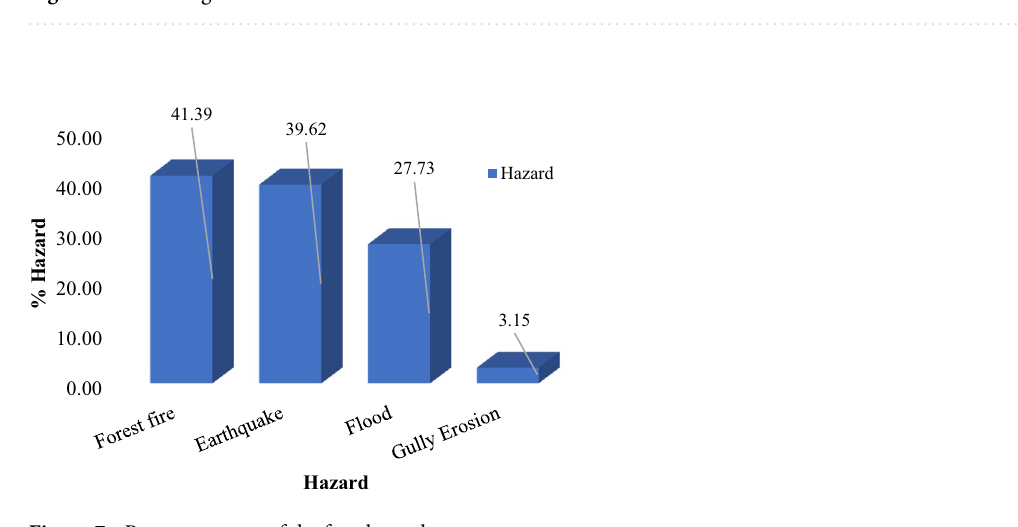
Figure 6. Percentages of areas of hazard classes.